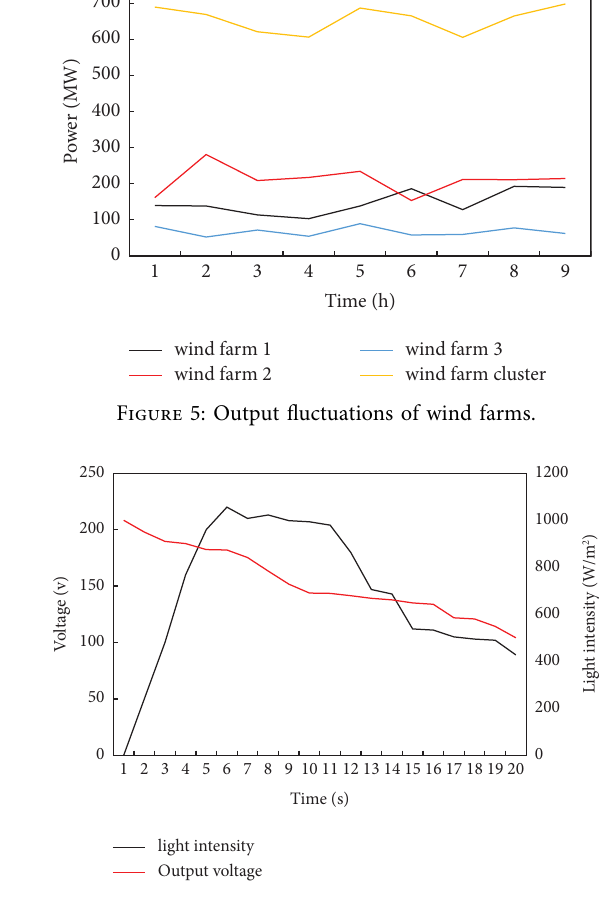
Figure 6: Output voltage waveform of 3 solar cell arrays in series (3000 W).